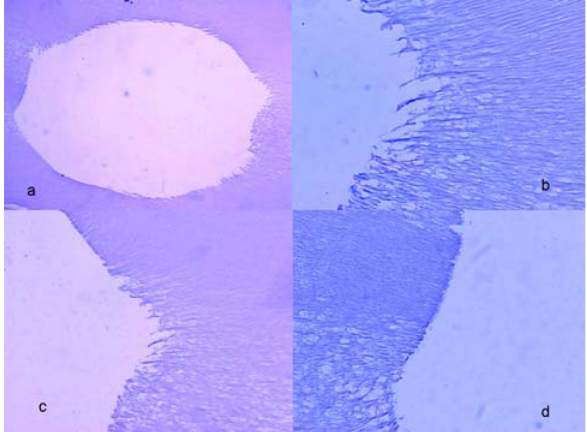
FIGURE 1- Group I- F1 instrument associated with 2.5% sodium hypochlorite irrigation (HE, a-40x; b-100x; c and d- 200x)